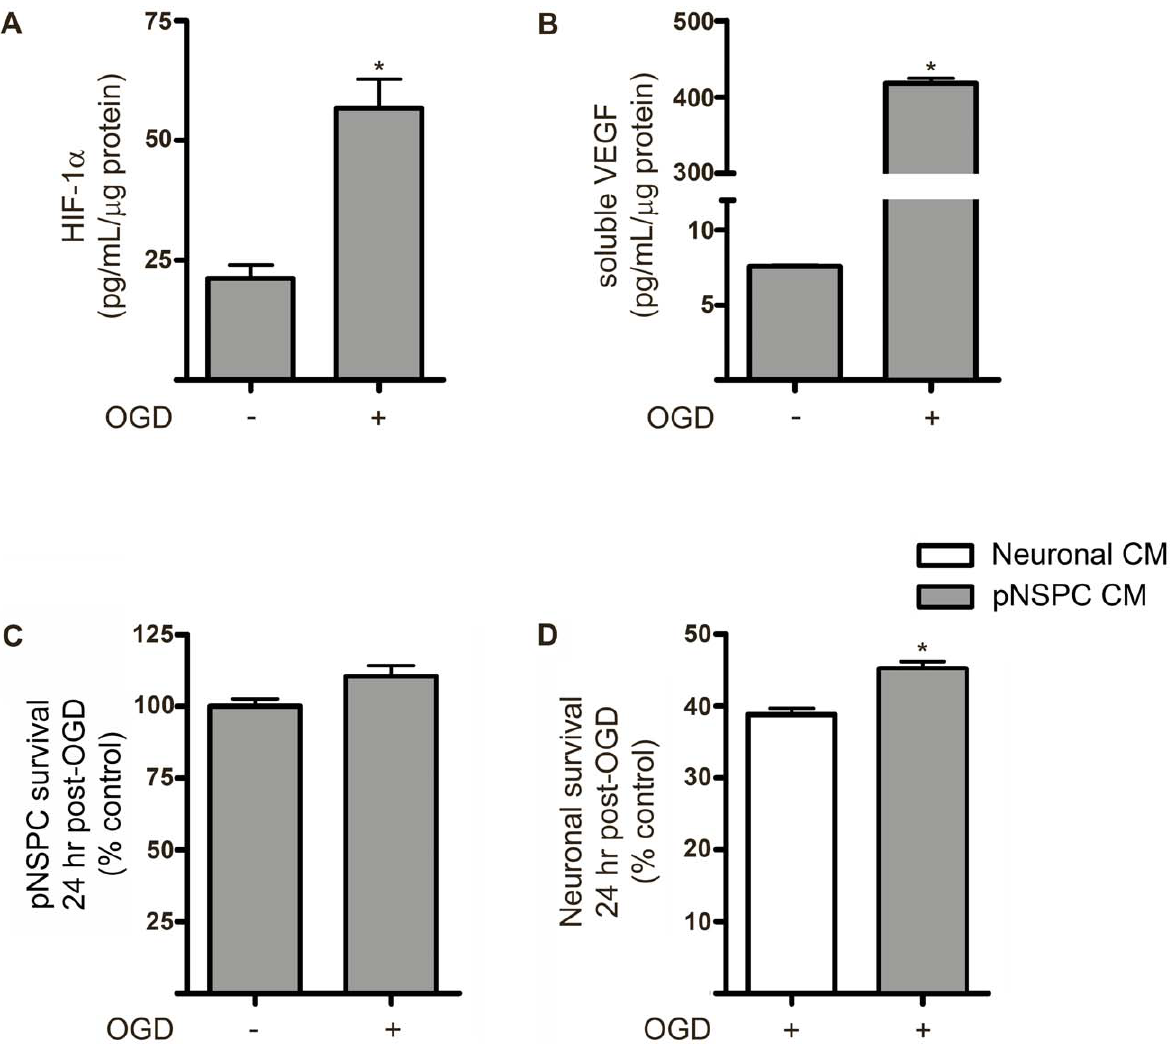
Figure 6. Postnatal NSPCs are neuroprotective and resistant to ischemia. ( A ) HIF-1 a protein levels in cell lysates and ( B ) VEGF concentration in conditioned medium from pNSPCs at 24 hr following 2 hr exposure to control or OGD conditions. ( C ) Viability of pNSPCs at 24 hr post-OGD. ( D ) Viability of cortical neuronal cultures 24 hr following 2 hr OGD in the presence of neuronal vs. pNSPC conditioned medium. *p , 0.05, n=4 cultures/ group.